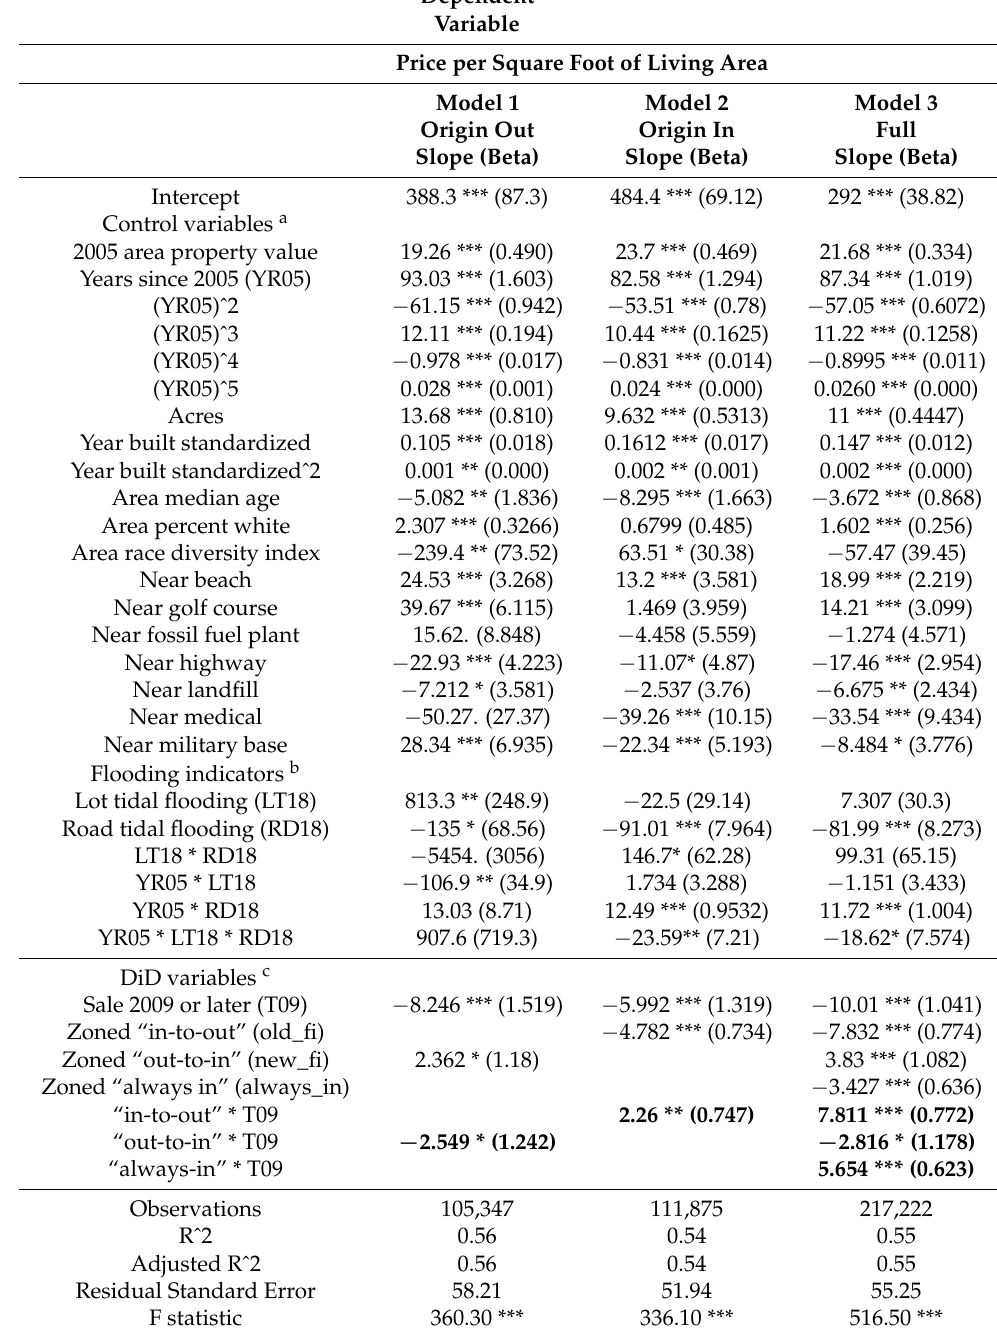
Table 4. Regression results predicting price per square